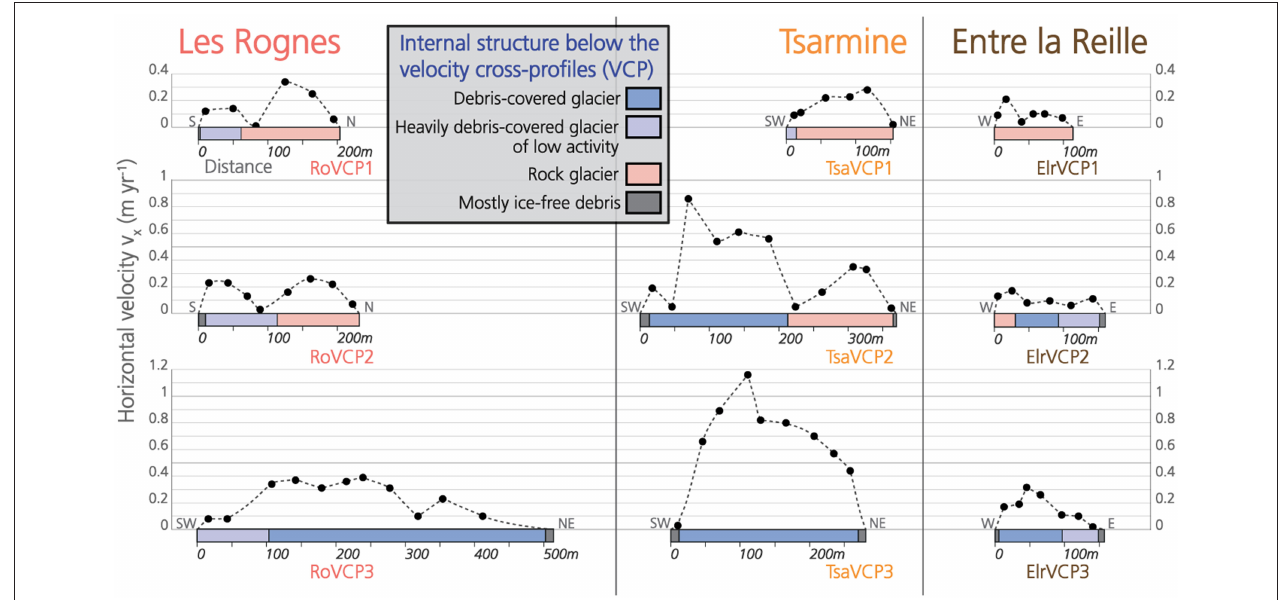
FIGURE 8 | Velocity cross-profiles (VCP) obtained from horizontal velocities between September 2011 and 2014 and internal structure below each profile. The 9 cross-profiles and the data used are depicted in Figure 6A .